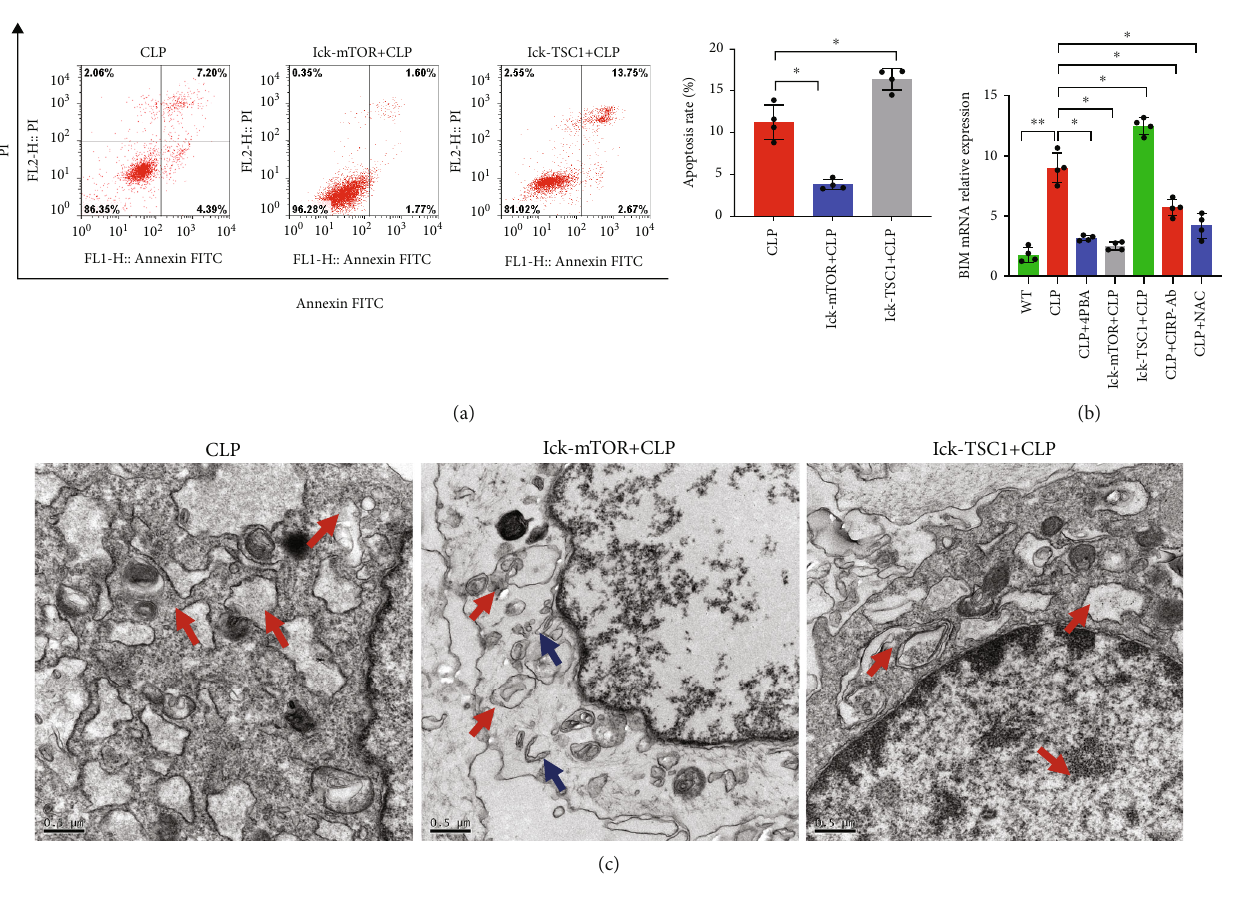
Figure 5: Role played by mTOR in ERS and CD4 + T cell apoptosis. CD4 + T cell apoptosis percentage was assessed by fl ow cytometry (a). Left panel: gating strategy for apoptosis cells; right panel: percentage of apoptotic cells in the left panel. Graphs show means ± SD , four mice per group. mRNA expression level of BIM in CD4 + T cells was analyzed by RT-PCR (b). Representative images of ER in CD4 + T cells from CLP, LCK-TSC1+CLP, and Lck-mTOR+CLP mice, as observed by electron microscopy (c). Data are mean ± SD , n = 4 , analyzed using one- way ANOVA. Blue arrows represent the normal-sized ER. Red arrows represent dilation of the ER. Scale bars = 0 : 5 μ m